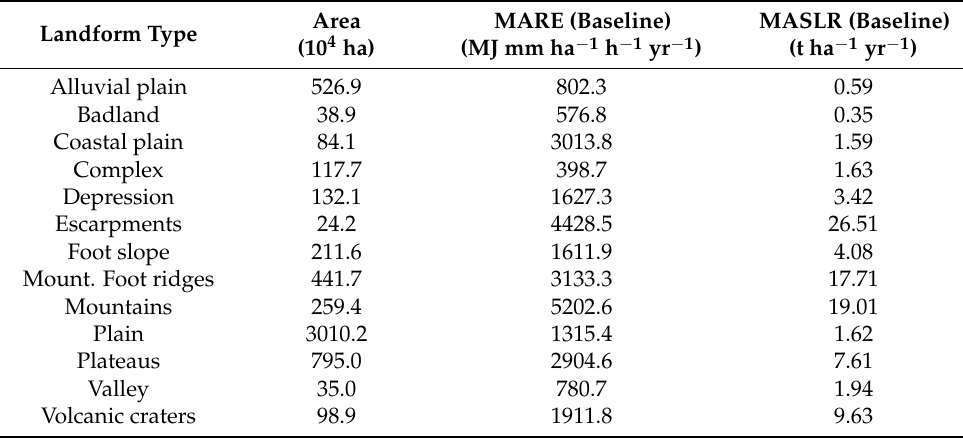
Table 13. Baseline soil erosion rates per landform types in